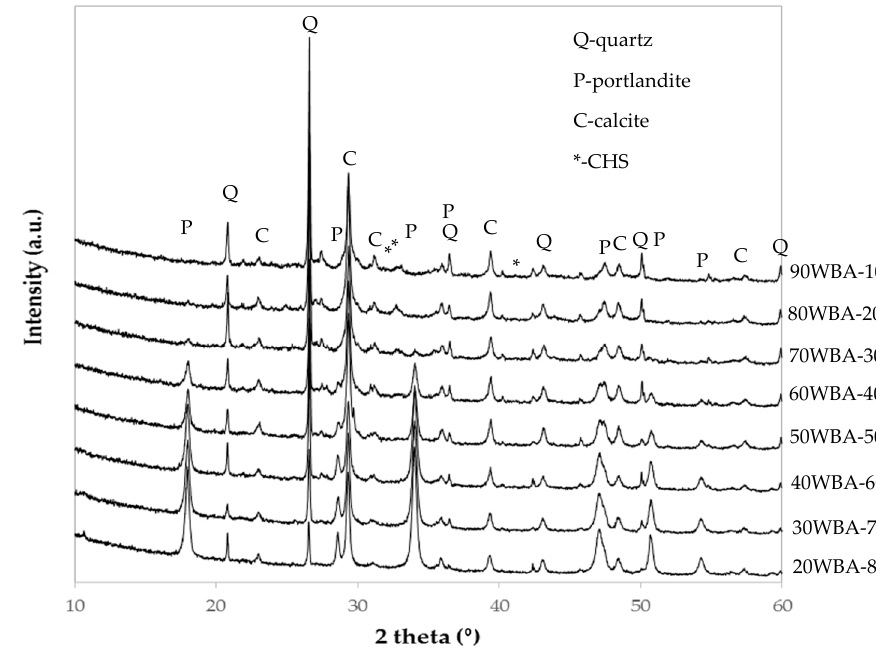
Figure 6. XRD patterns of calcium silicate units.